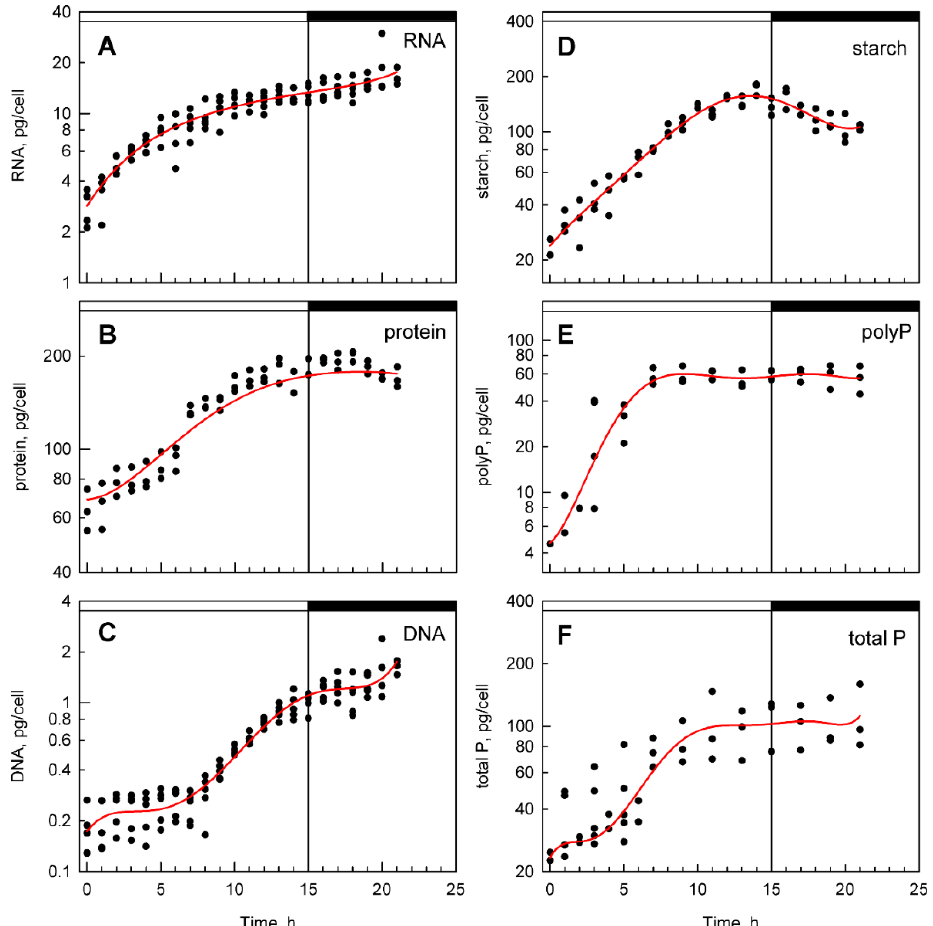
Figure 2. Time courses of accumulation of RNA ( A ), protein ( B ), DNA ( C ), starch ( D ), polyP ( E ), and total phosphates ( F ) in synchronized cultures of D. quadricauda . Light (15 h) and dark periods (7 h) are marked by stripes above panels and separated by a vertical line. Values from five different experiments are shown as dots, the smoothed red line representing the mean of five experiments in each panel. Values were calculated per parental cell even if divided (17:00 to 22:00 h).